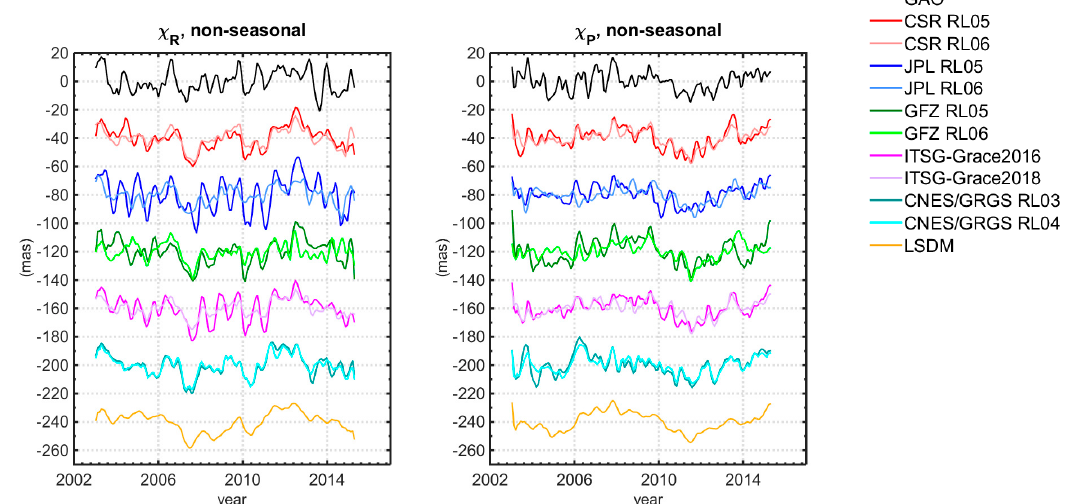
Figure 3. Retrograde and prograde parts ( χ R and χ P , respectively) of non-seasonal variation in GAO, in HAM computed from different GRACE solutions, and HAM from the LSDM. The units are milliseconds of arc (mas). For better visibility, a bias was added to various HAM in order to shift them relative to each other.